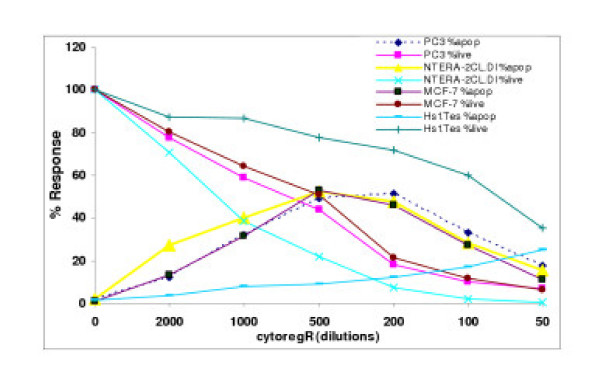
Correlation of % viable cells as assessed by the Trypan blue exclusion assay and apoptosis in treated cells. Percentage apoptotic cells was determined by the TUNEL DNA fragmentation assay as described. The treatment-induced reduction in viable cells corresponded with simultaneous increase in apoptotic cells at corresponding dilutions/concentrations of cytoregR. The data points represent the means ± SEM of triplicates from two independent experiments.